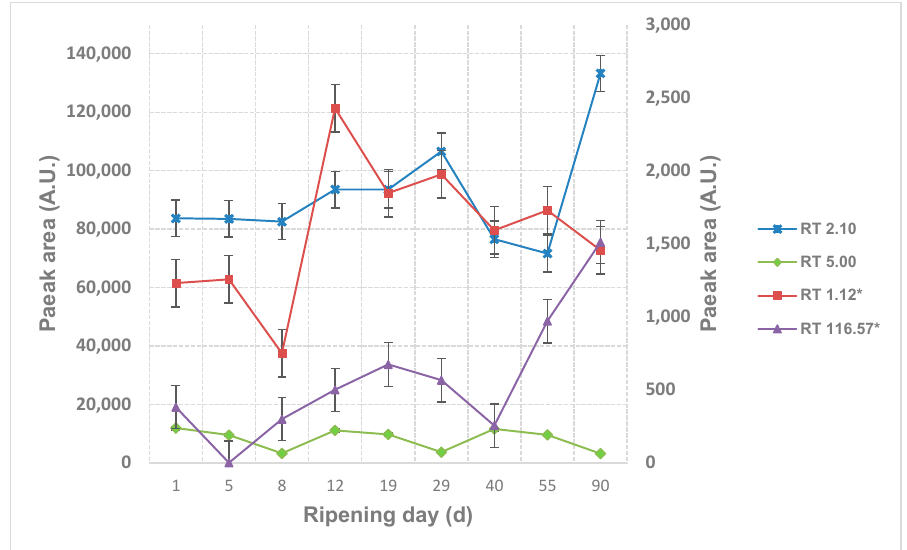
Figure 3. The evolution of peptides throughout the ripening process. NPN fraction where 4 main peaks are observed. RT: retention time of the selected peak. * Values in the secondary axis.